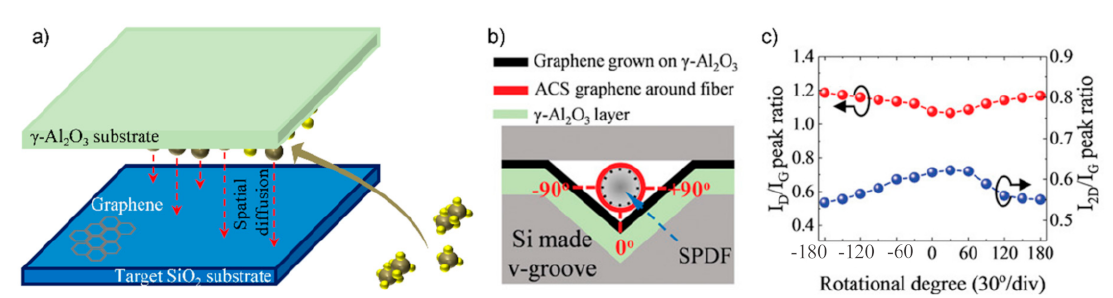
Figure 6. ( a ) Schematic representation of graphene growth on the targeted surface by spatial diffusion; ( b ) Schematic of the setup for synthesizing graphene around the 3D structured fiber by the ACS process; ( c ) Raman intensity ratio of I D /I G (red curve) and I 2D /I G (blue curve) acquired from the fiber perimeter. ( a – c ) Reproduced with permission from [109]. Copyright WILEY-VCH Verlag GmbH & Co. KGaA, Weinheim,